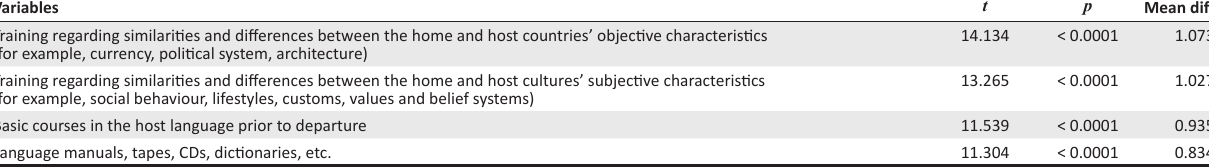
TABLE 5: Individual t -test results for training required versus training provided. Variables